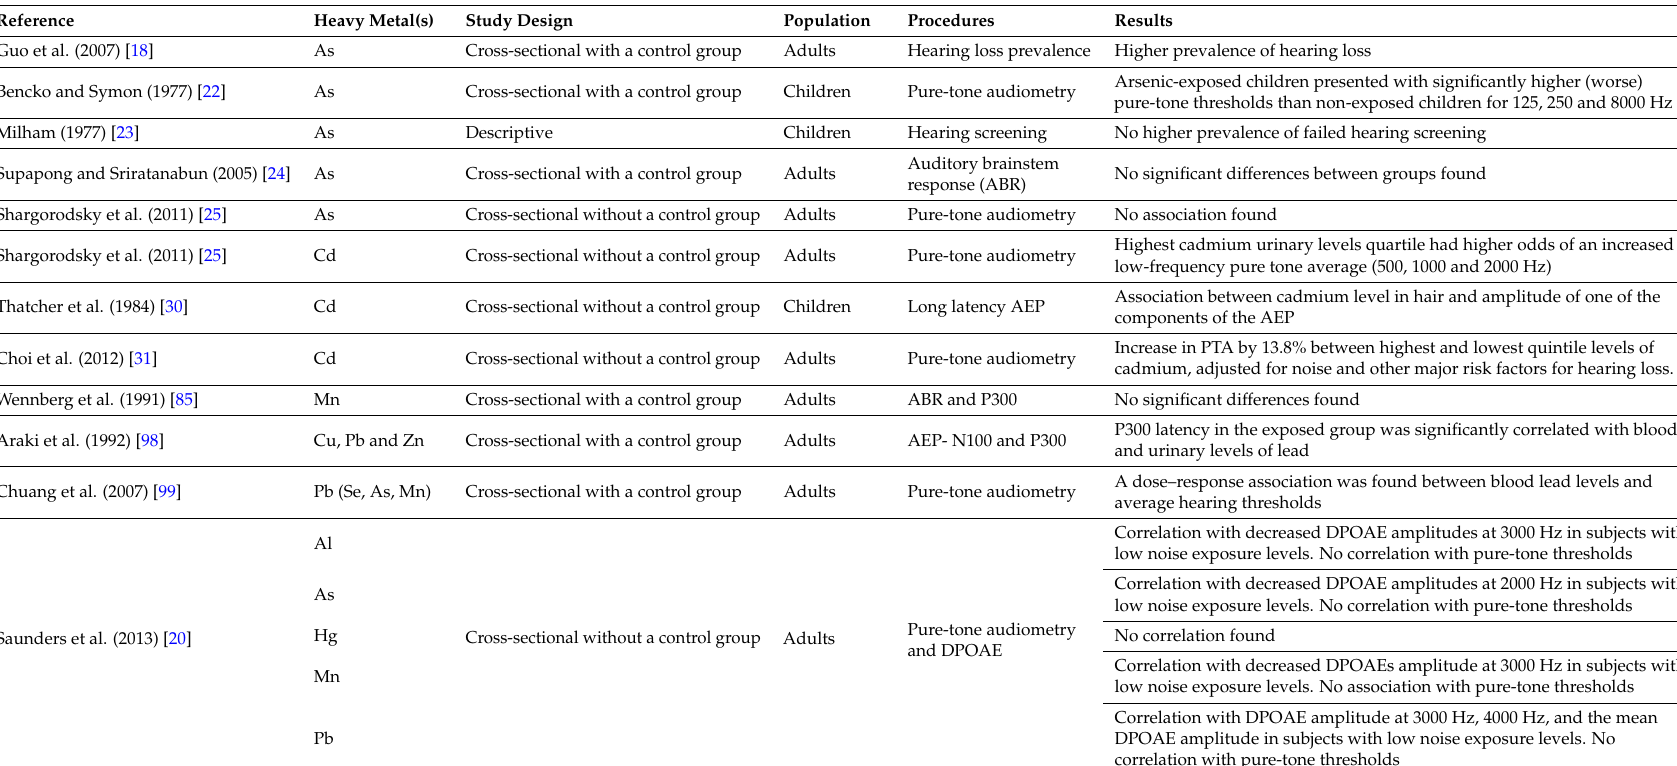
Table 1. Summary of studies investigating the effects of arsenic, cadmium, manganese and mixture of heavy metals exposure in adults and